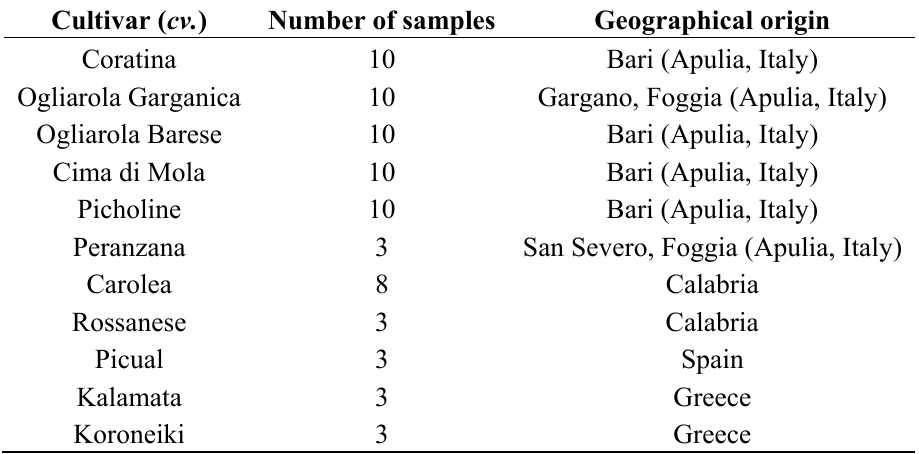
Table 1. Cultivar, the number of samples and the area of origin of the monocultivar authentic extra virgin olive oils (EVOOs)